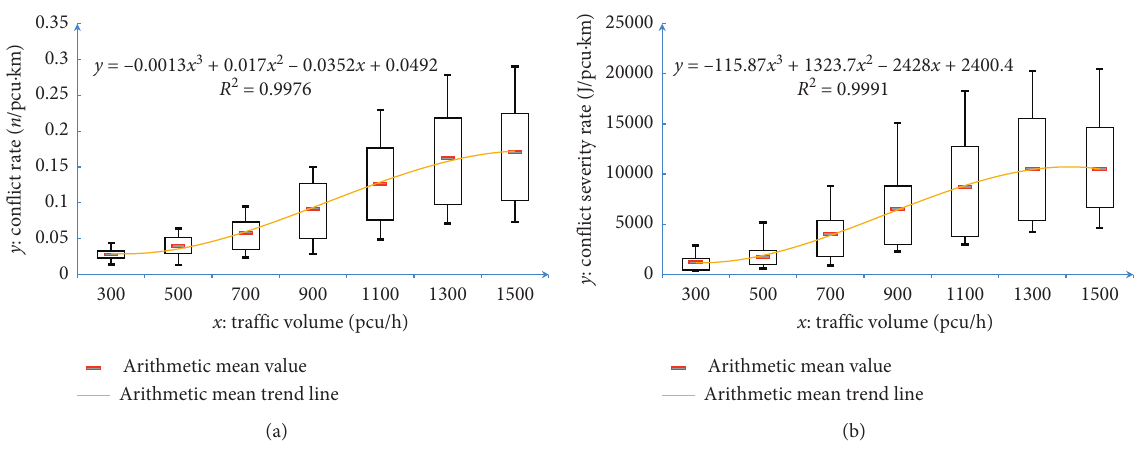
Figure 10: Distribution of traffic conflict rates and severity rates under different traffic